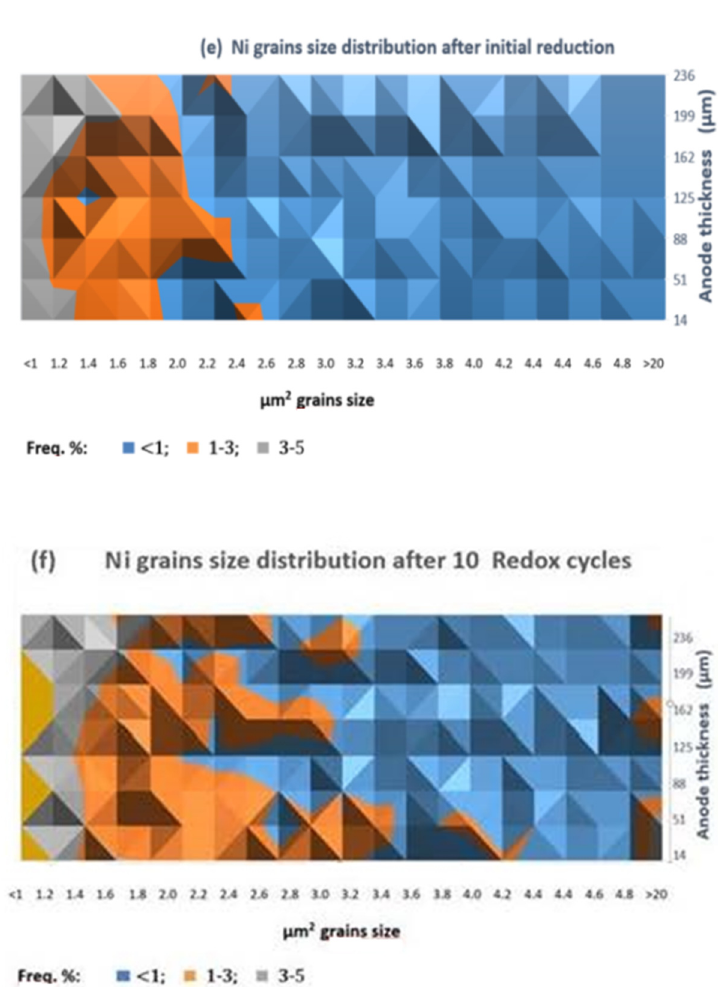
Figure 6. SEM-BSE image analysis of bare anode: ( a ) Ni grains distribution after initial reduction; ( b ) Ni grains distribution after 10 redox cycles (red—Ni; black—pores; grey—YSZ); ( c ) Porosity after initial reduction; ( d ) Porosity after 10 redox cycles; ( c,d ) Ni grain size distribution; ( e ) Ni grains size distribution after initial reduction; ( f ) Ni grain size distribution after 10 Redox cycles.